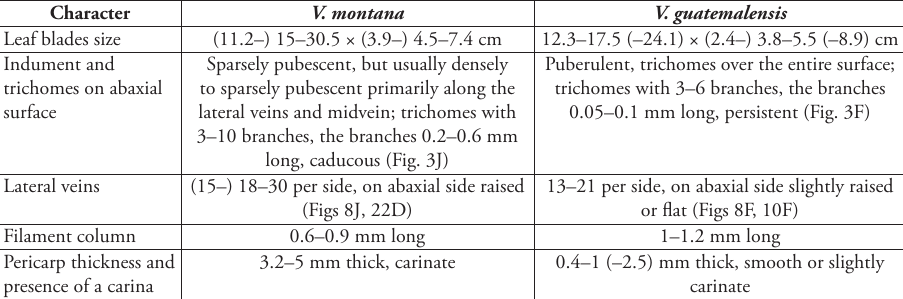
Table 6. Morphological differences between Virola montana and V.